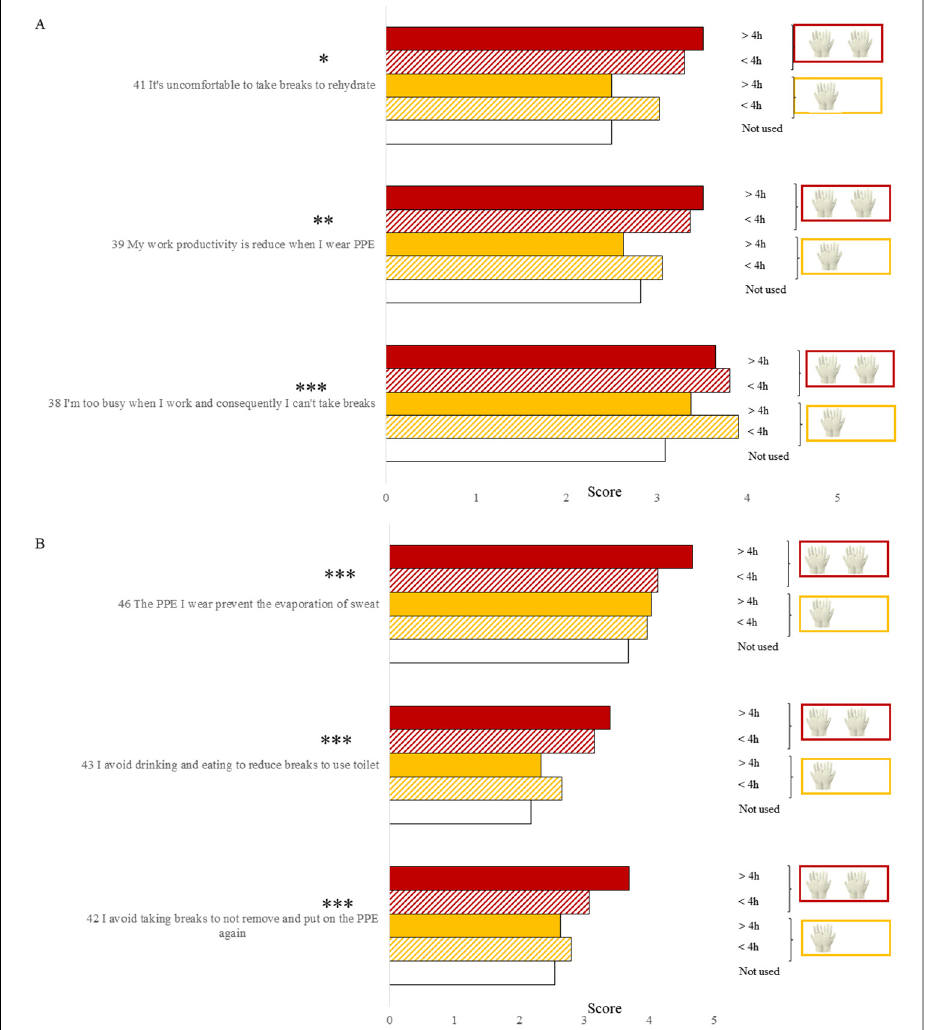
Figure 4. ANOVA to evaluate the effect of the use of the gloves on the answers related to items 38, 39, 41 ( A ) and items 42, 43, 46 ( B ). One or two pairs of overlapping gloves and dif-ferent time of use (<4 h or >4 h) was considered. A 5-point Likert scale (1 for strongly disagree and 5 for strongly agree) was used for questions. (Sig): *** p < 0.001; ** p < 0.01; * p < 0.05.